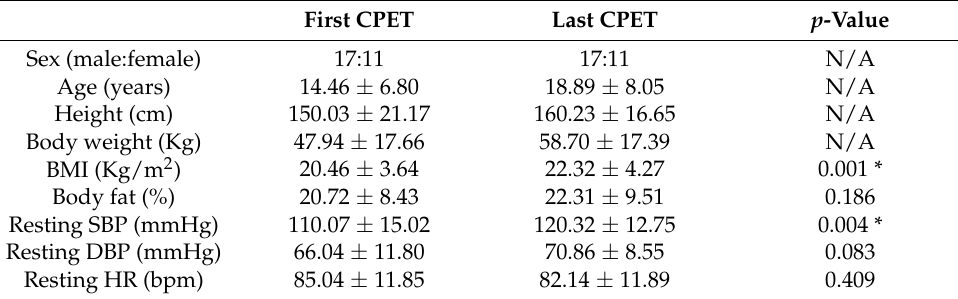
Table 1. Demographic characteristics of patients with pulmonary valve